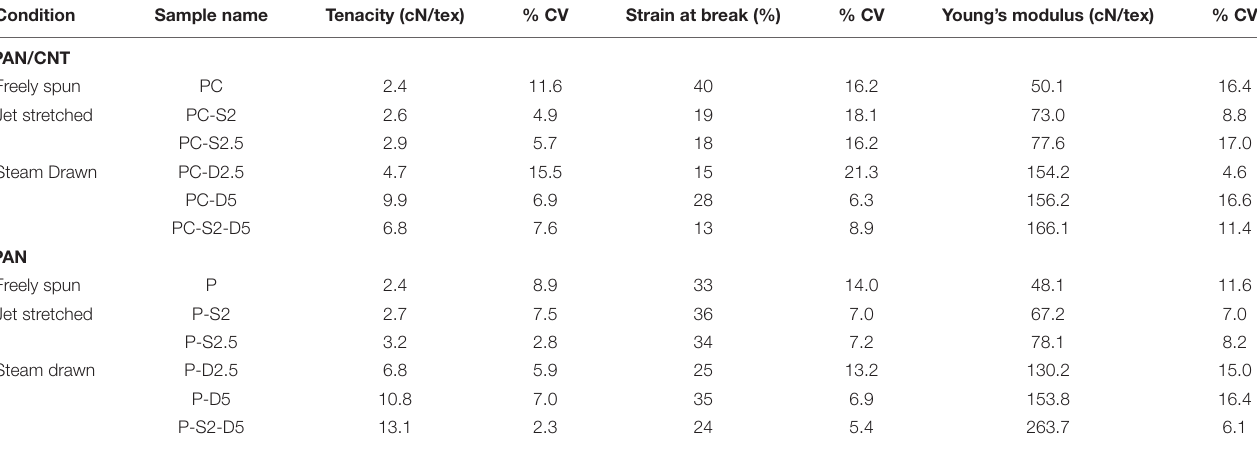
TABLE 5 | Mechanical properties of PAN/CNT and PAN reference fibers at different stretching conditions.